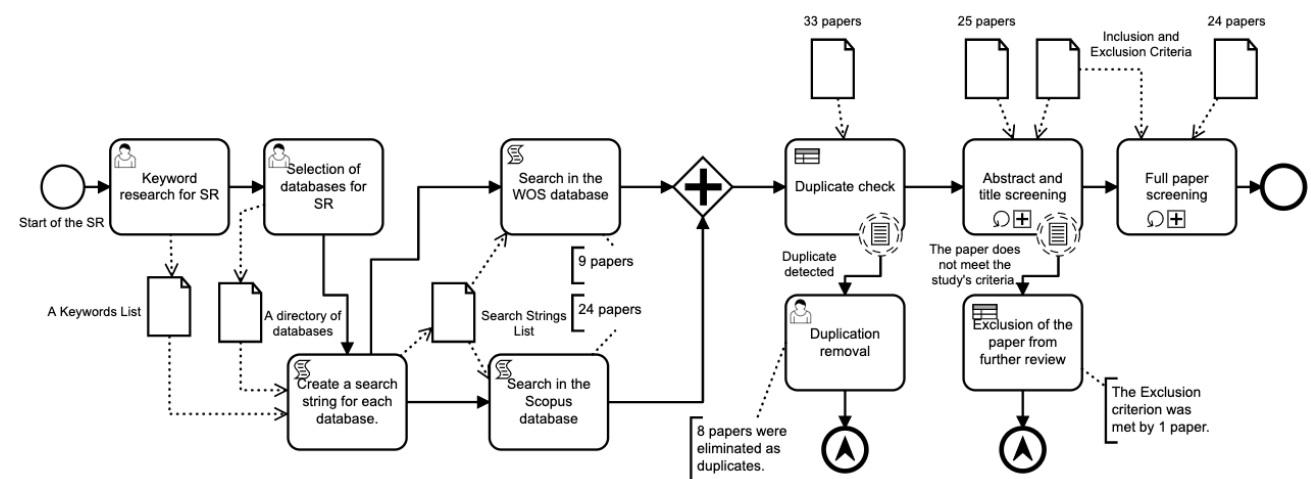
Figure 2. Process of Systematic